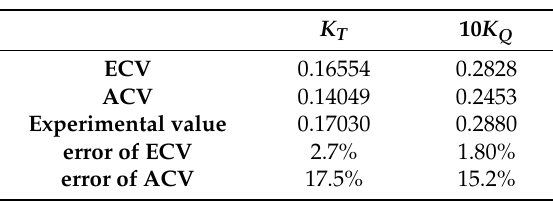
Figure 7. Thrust and torque of propeller. (ECV and ACV represent effective wake calculated value and apparent wake calculated value, respectively). Table 4. Error analysis.